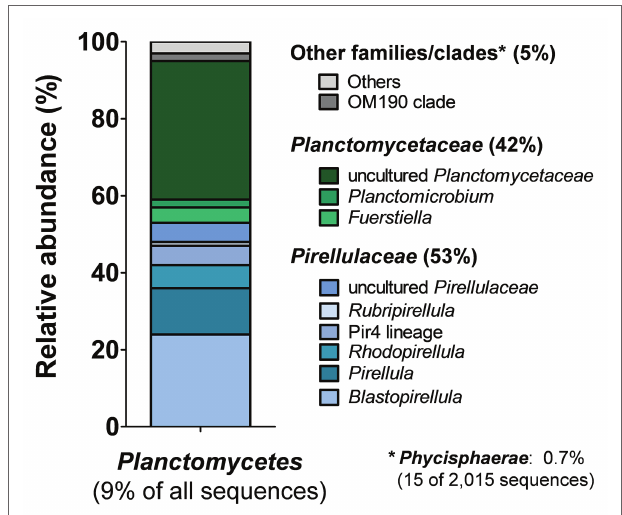
FIGURE 2 | Analysis of amplicon sequences belonging to the phylum Planctomycetes . Of the total number of 22,364 partial 16S rRNA gene sequences, 2,015 (9.0%) belong to strains of the phylum Planctomycetes . Relative abundances with regard to the planctomycete-derived sequences (2,015 sequences = 100%) were further analyzed on the order/family or genus